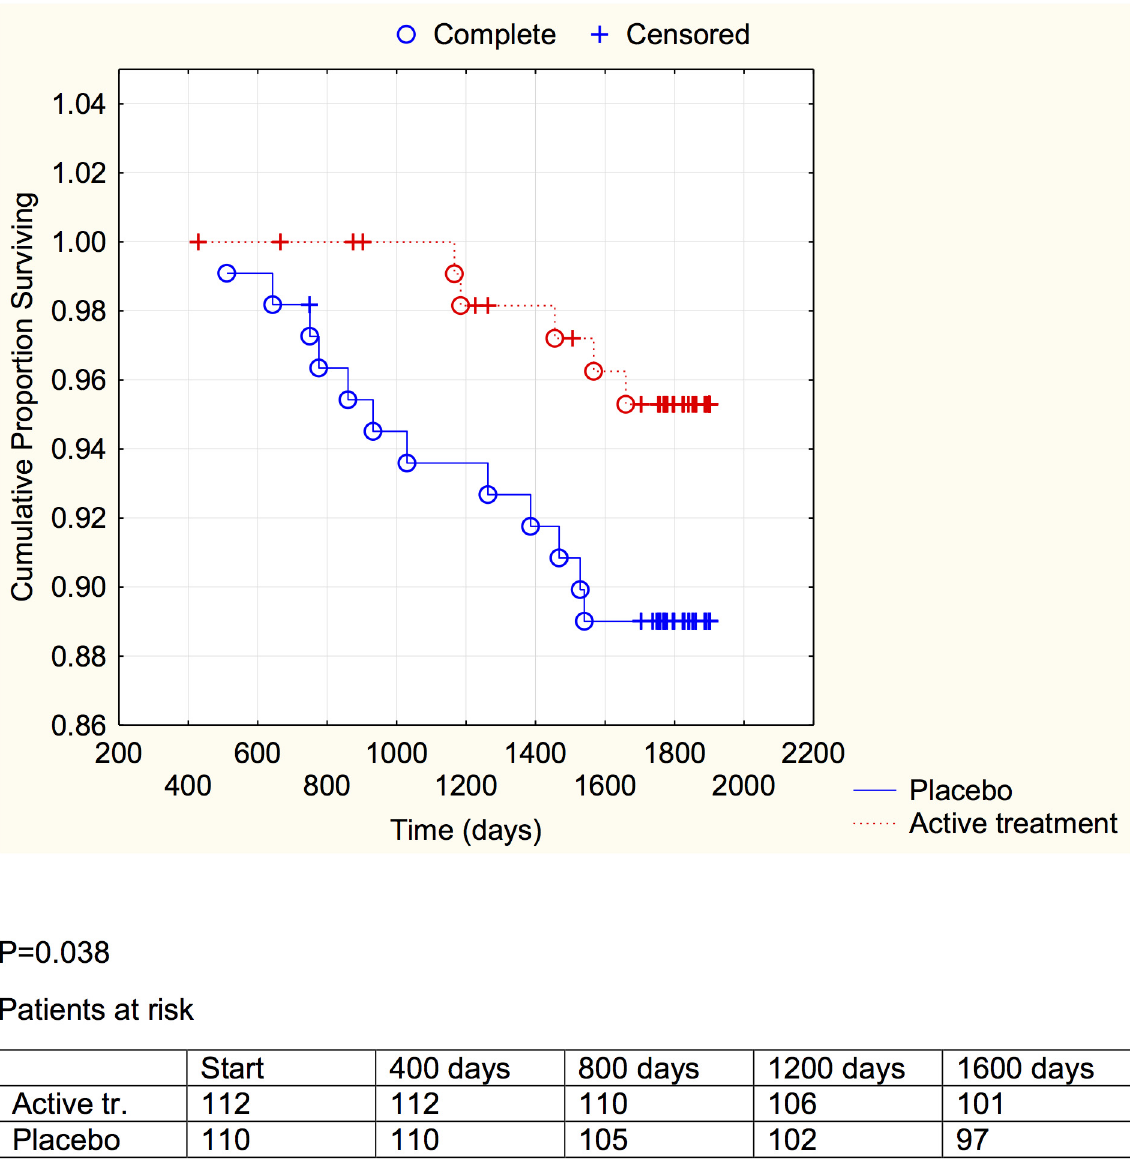
Fig 6. Distribution of cardiovascular mortality among those with a sP-selectin concentration below median in those who received active supplementation of selenium and coenzyme Q10 combined versus placebo during follow-up of 5.2